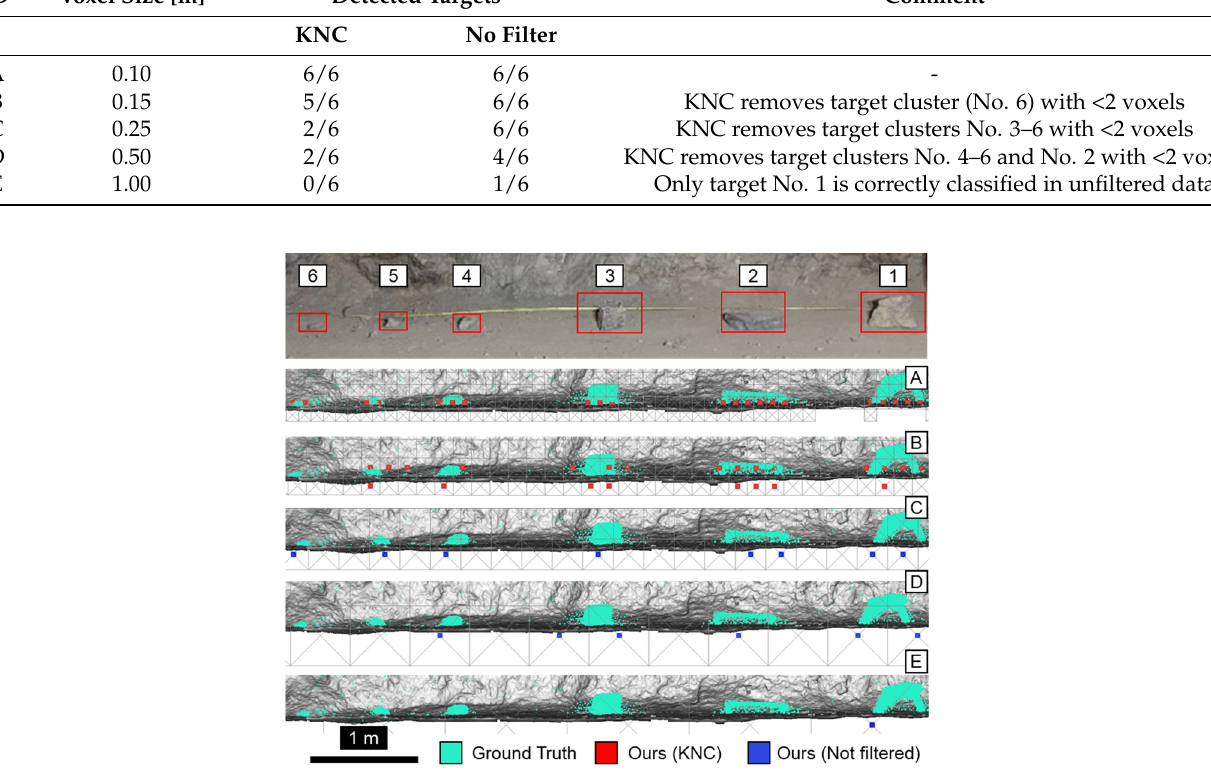
Figure 9. Results of rockfall and voxel size test in FDS1 V1 with six progressively smaller rocks (1–6) from edge lengths from 0.25–0.03 m. Comparison of results for voxel sizes (A: 0.1 m, B: 0.15 m, C: 0.25 m, D: 0.5 m, E: 1.0 m).